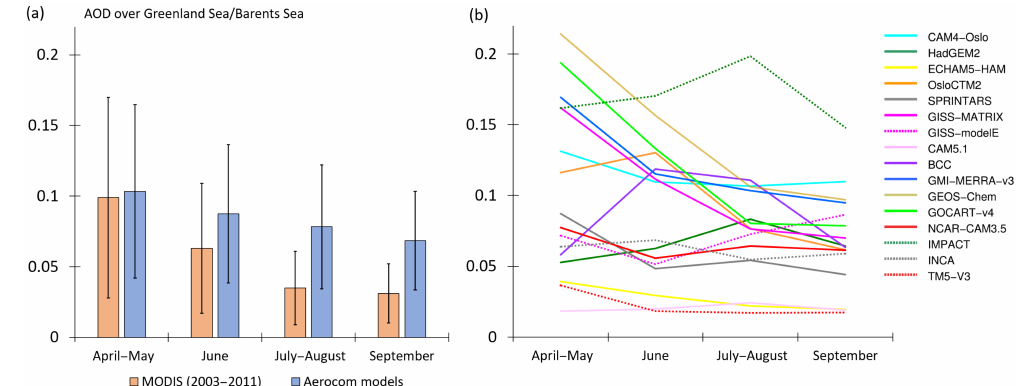
Figure 5. AOD over the Arctic Ocean (75–82 ◦ N, 10 ◦ W–40 ◦ E) from (a) MODIS retrieval 2003–2011 median (orange) compared to the AeroCom Phase II model mean (blue) and (b) the individual models. The error bars in (a) represent 1 SD.